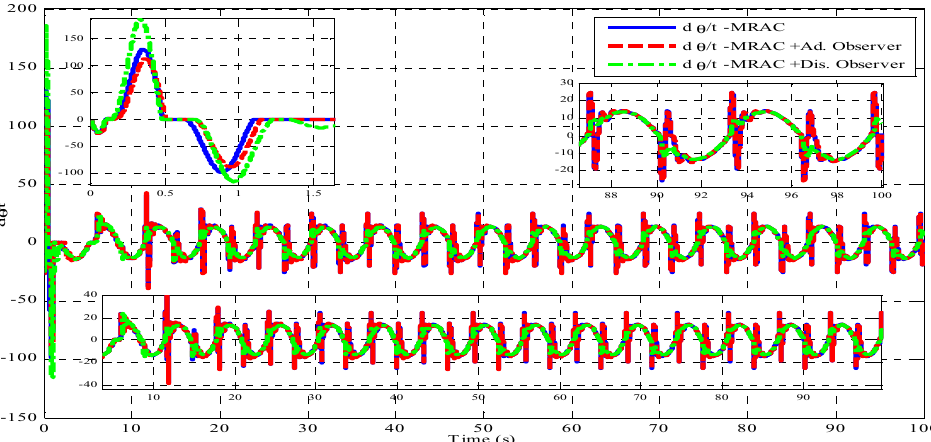
Figure 4. Exoskeleton knee assisted system speed response for the three controllers.